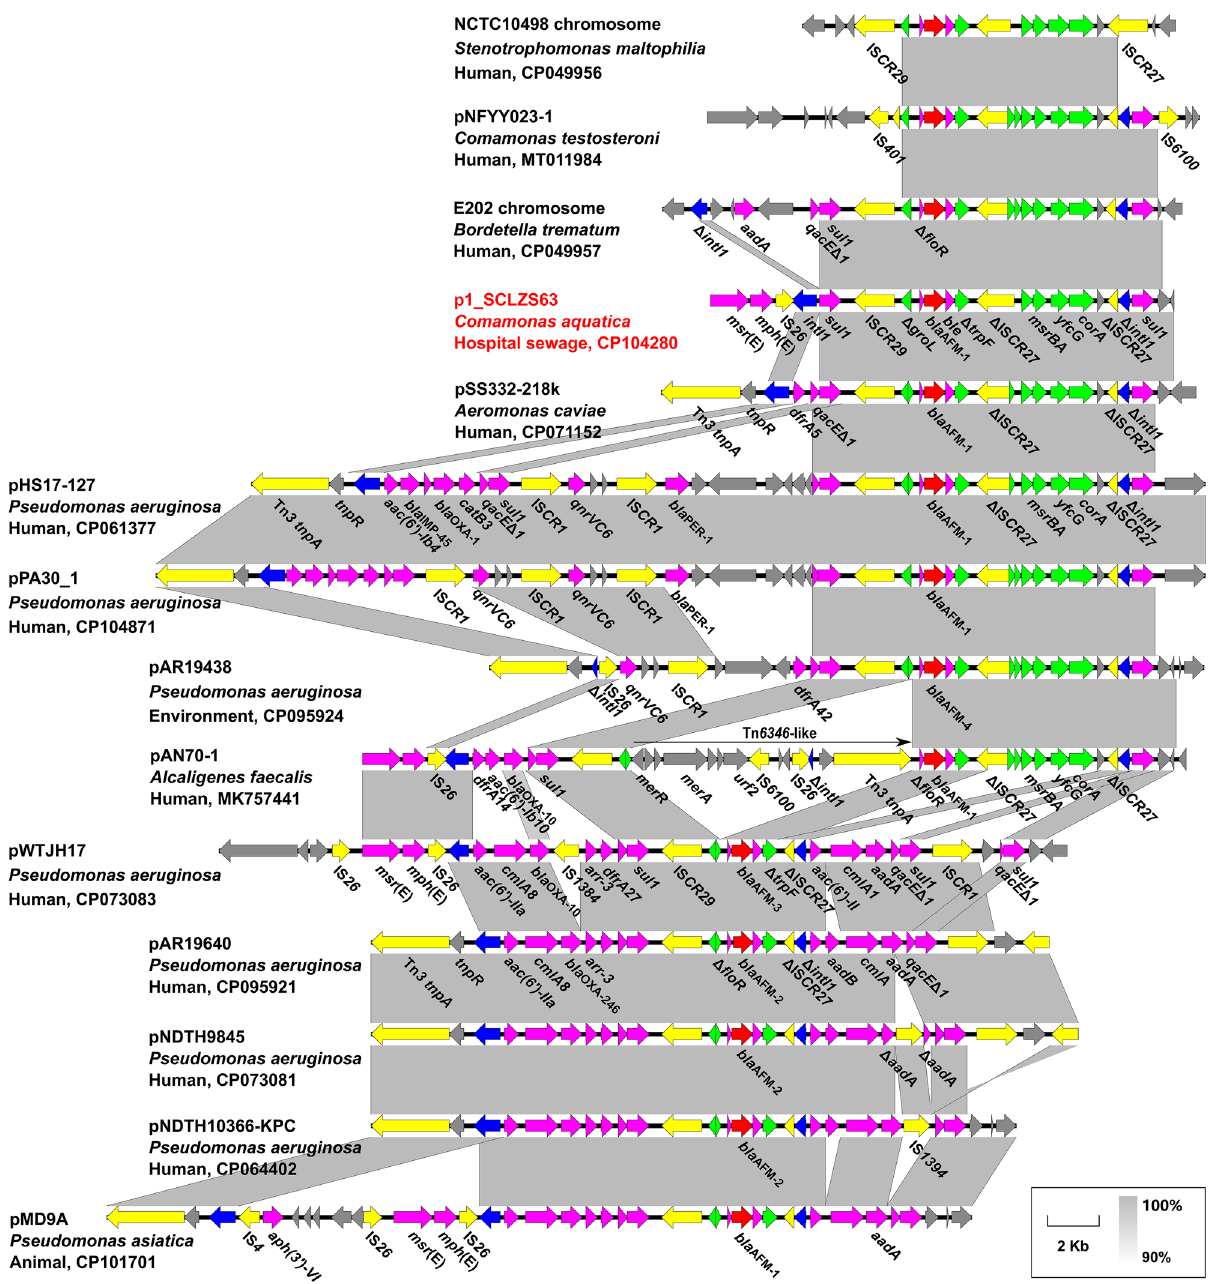
Figure 4. The genetic contexts and mobilization mechanisms of bla AFM genes. The position and transcriptional direction of ORFs are indicated by arrows. The bla AFM genes are highlighted in red and other resistance genes are in fuchsia. Insertion elements and integrase genes are colored yellow and dark blue, respectively. Genes in the bla AFM -bearing core module are indicated in green. The strain or plasmid names, species, isolation sources, and GenBank accession numbers are shown. Δ represents truncated genes or